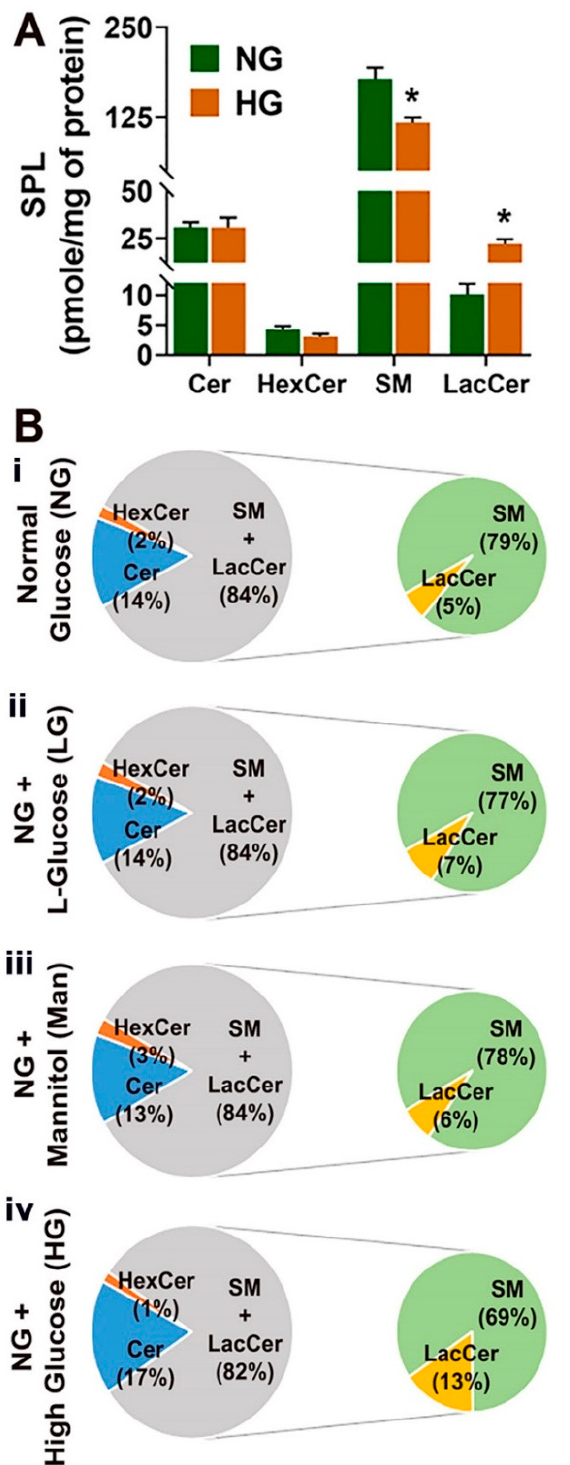
Figure 3. Analysis of major SPL classes in HREC cultured in 5 mM glucose (NG), 25 mM glucose (HG), NG + 20 mM L-glucose (LG), and NG + 20 mM mannitol (Man)-containing media for 48 h. ( A )